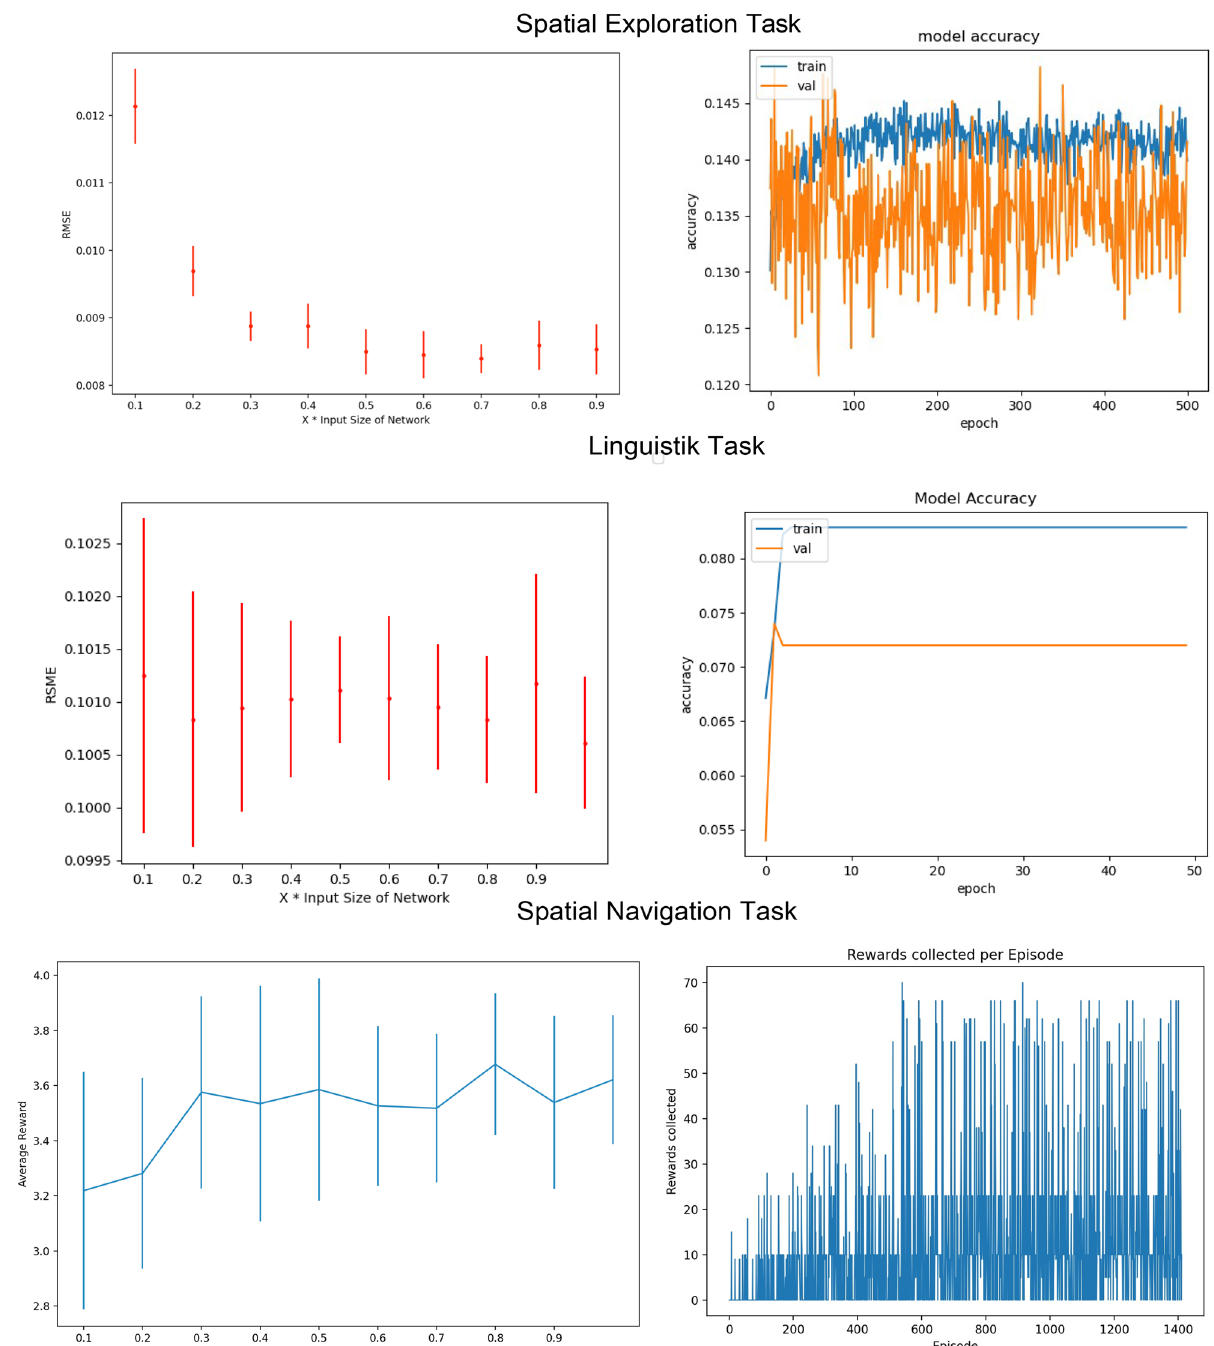
Figure 2. Evaluation of the models with regard to architecture and performance during training. Top: Evaluations for the spatial exploration model. The network’s architecture is tested depending on the size of the hidden layer. Different sizes depending on the input size in comparison to the RMSE of the predicted transition probability matrix and the ground truth matrix are shown. The error decreases with the size of the hidden layer until 30% of the input size. After that the error saturates. The accuracy of the model during training and validation increases shortly at the beginning from 0.13 to 0.14, afterwards it stagnates. The low accuracy of the model is connected to the potential 9 different successor states of each starting state which are randomly sampled as label. However the RMSE is low in all cases. Middle: In the linguistic task the hidden layer size does not play an important role. The RMSE stays similar for all configurations. The accuracy for the model also jumps at the beginning to around 0.08. The low accuracy can be again explained by up to possible ten randomly sampled successor states. Hover the RSME regarding the ground truth is low again. Bottom: The architecture for the spatial navigation task also does not influence the performance much. The average collected reward increases until 30% of the input size and subsequently saturates. During training, the model improves the received reward continuously until around 600